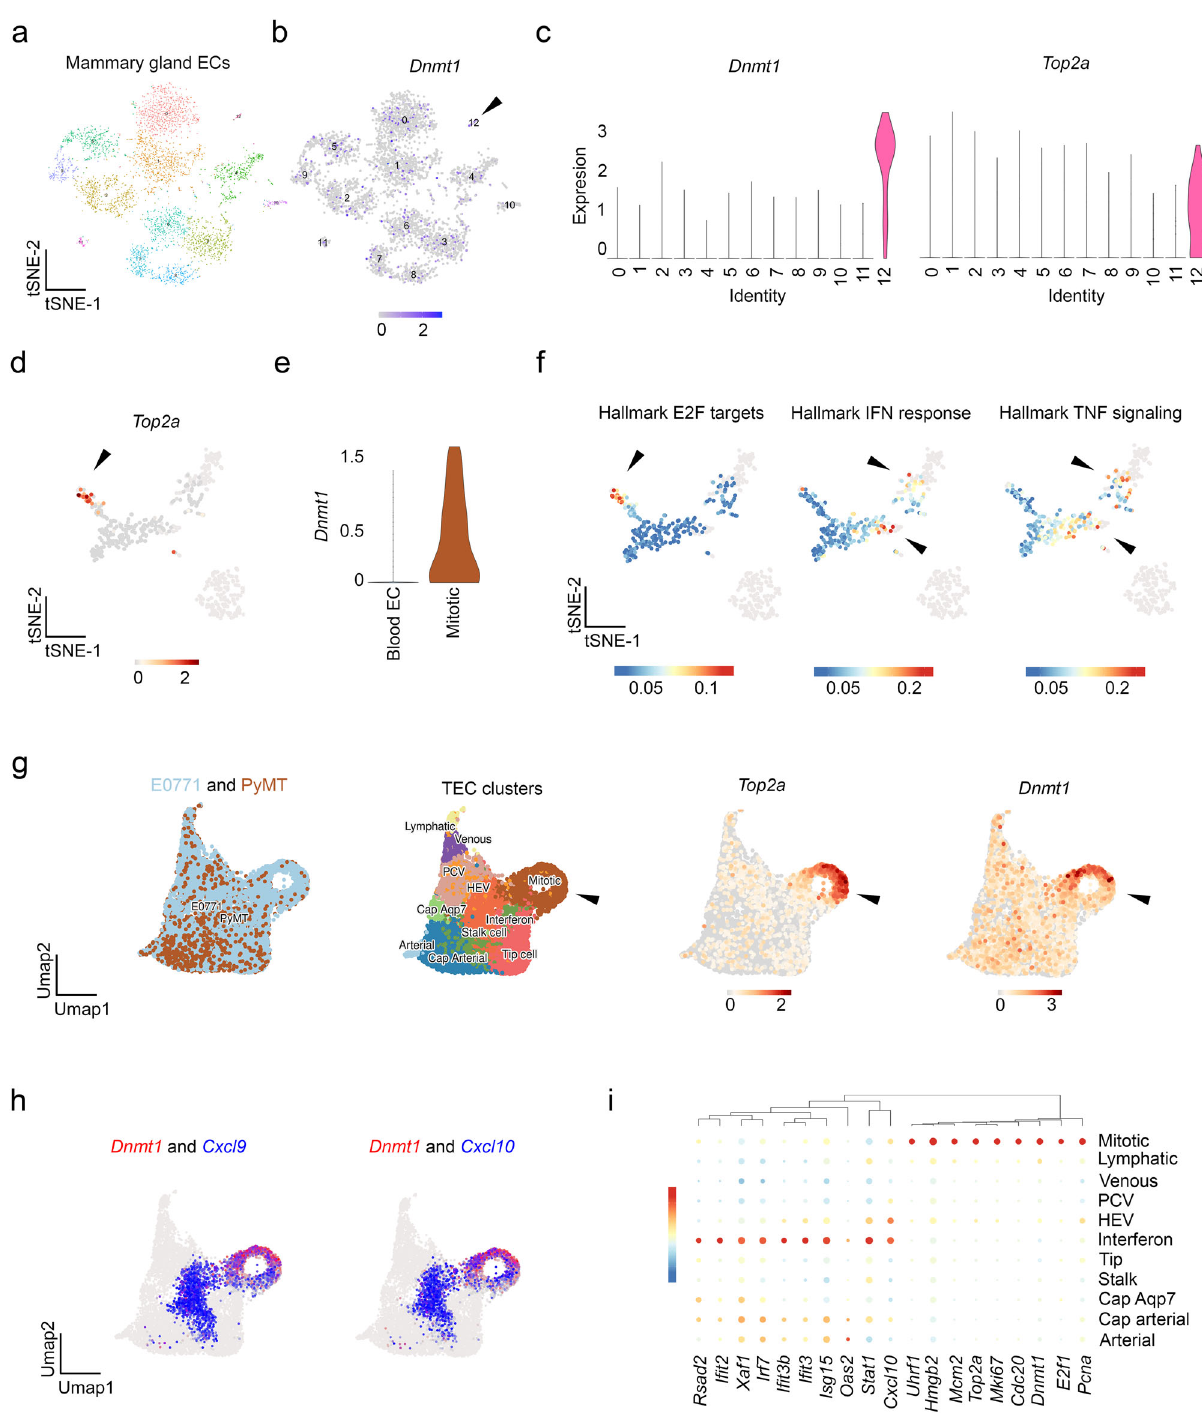
Fig. 5| ScRNA-sequencingrevealsproliferativeTECsthatarediminishedinIFN andTNFresponsegenes.a tSNEplotofnormalmammaryglandECsisolatedfrom pooled ( n = 20 ) mammary glands. b tSNE plot showing Dnmt1 expression amongst the different clusters. The arrowhead points to cluster 12. c Violin plots showing enrichment of Dnmt1 and Top2a in cluster 12. d tSNE plot showing Top2a expres- sioninPyMTTECs. e Dnmt1 expressioninbloodversusmitoticTECsfromthePyMT